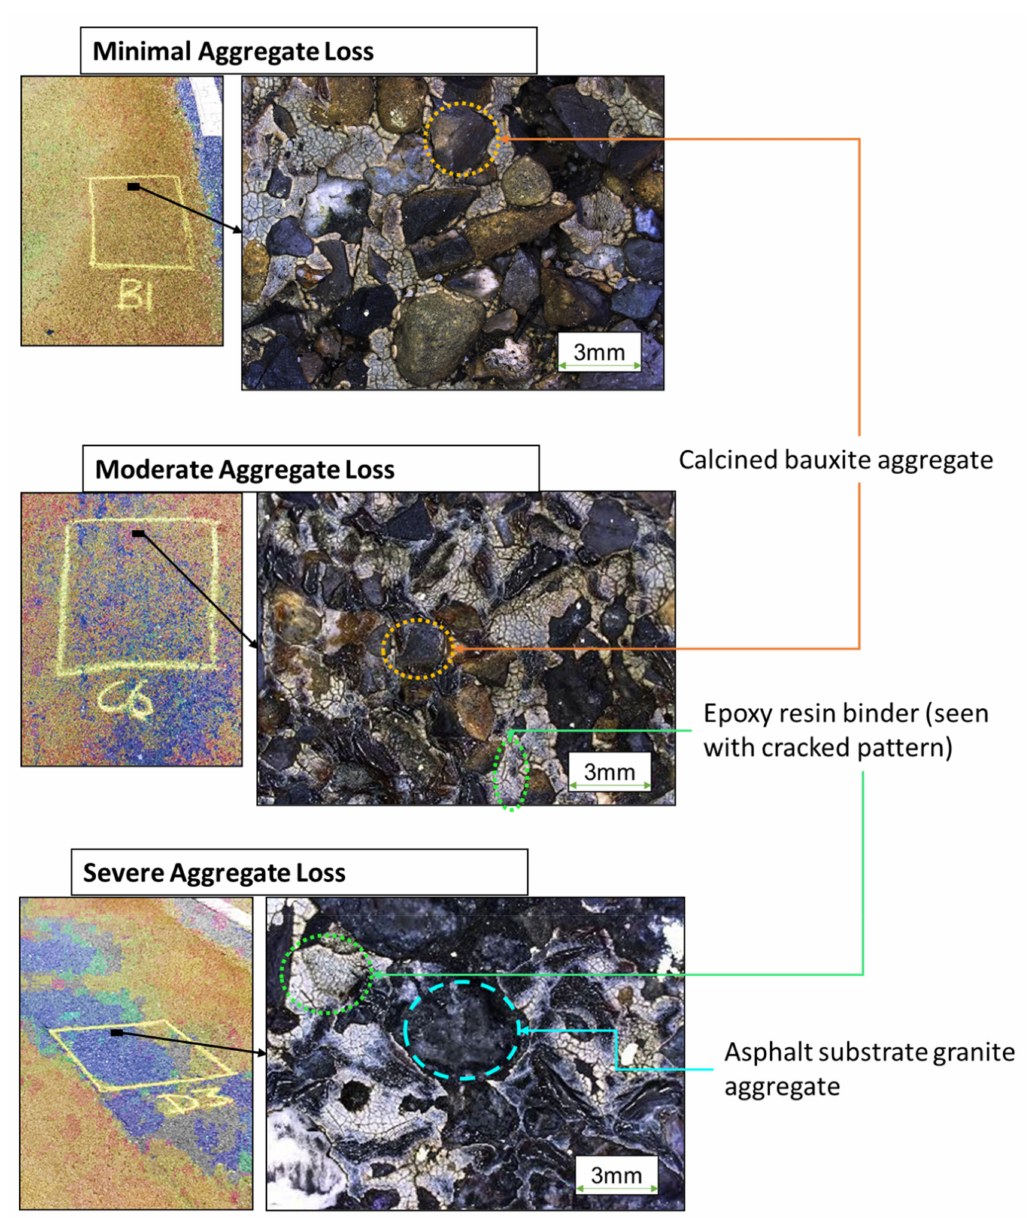
Figure 12. Photos showing example of three different aggregate loss severity types and microscopic image of the corre- sponding severity type. The photos (left) are enhanced with 400% saturation to distinguish calcined bauxite aggregates (represented as yellow) from epoxy and background asphalt aggregates (represented as green and